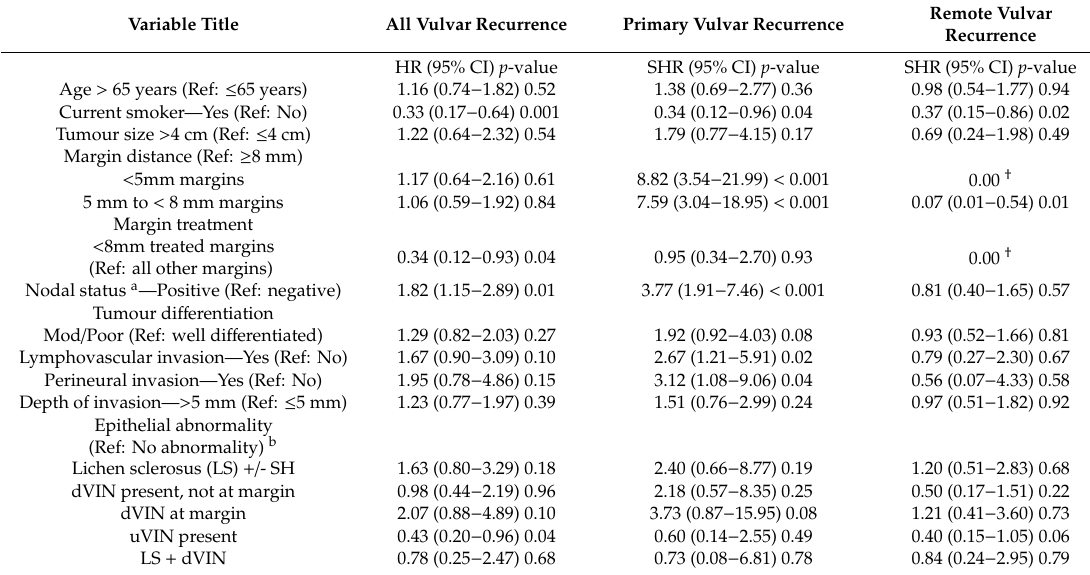
Table 2. Univariable Cox and Fine-Gray regression analyses comparing all vulvar recurrences, and primary and remote site vulvar recurrences with clinico-pathological